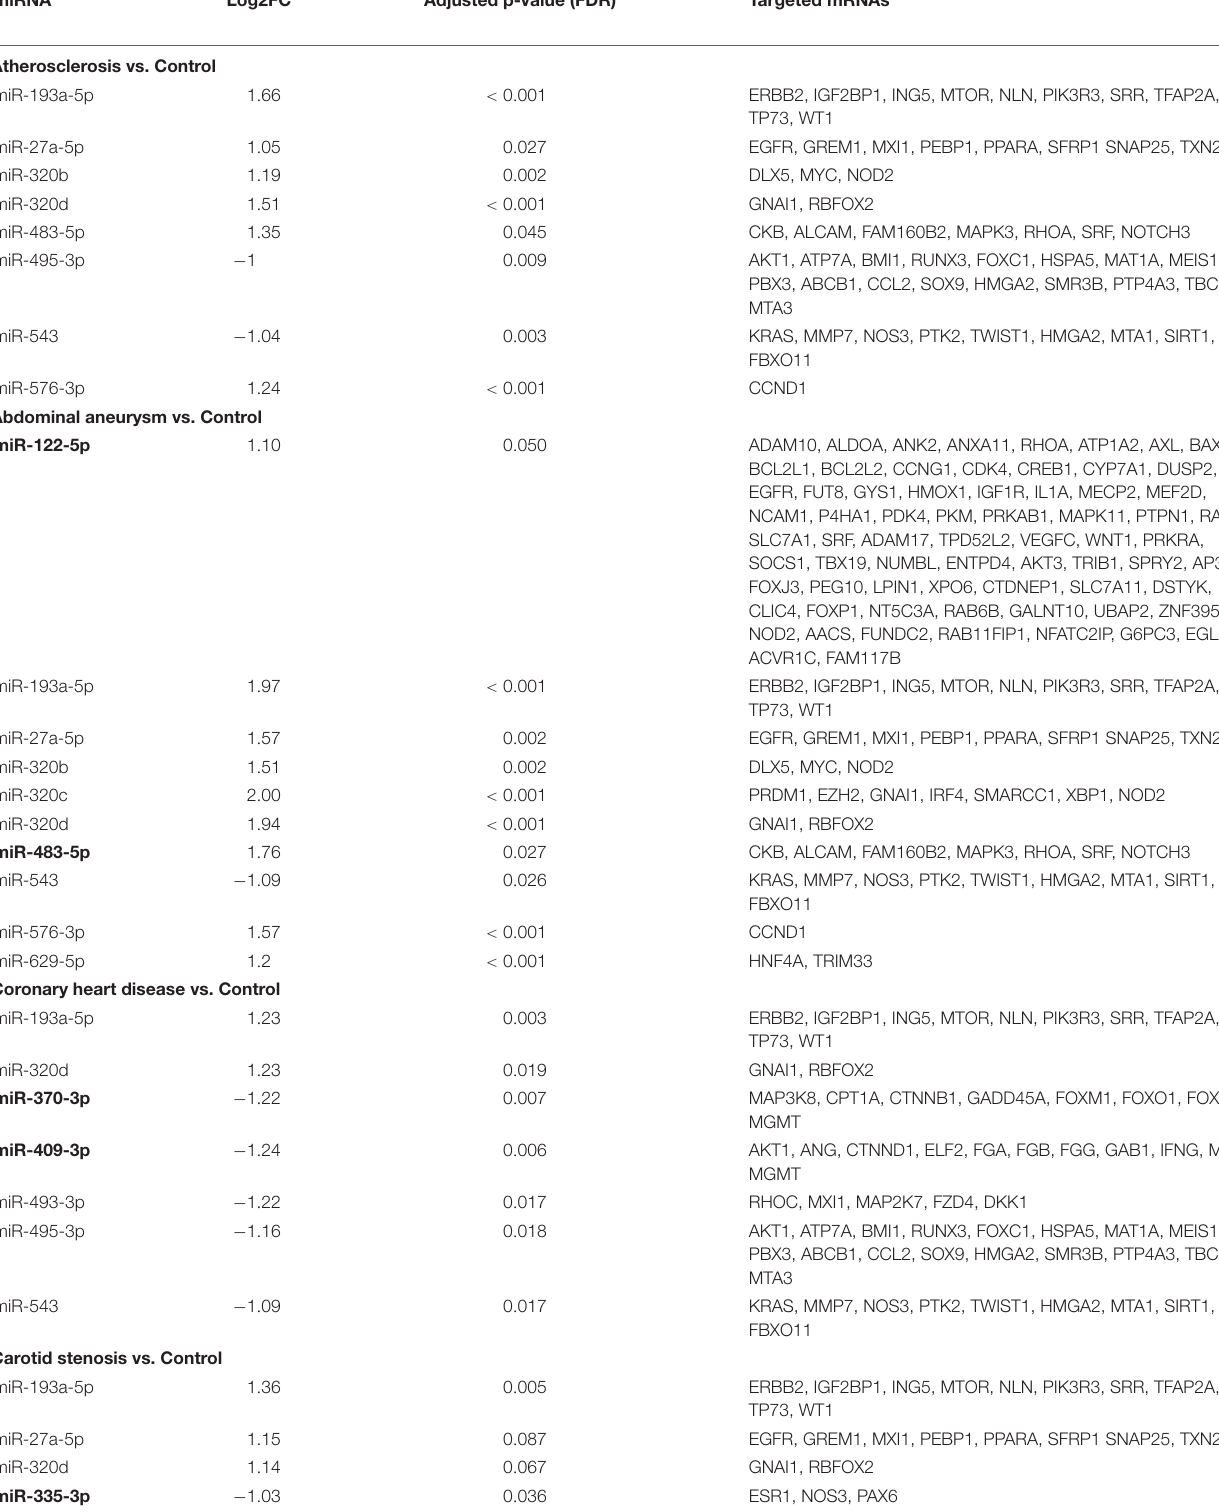
TABLE 6 | Differentially expressed miRNAs and their targeted mRNAs. miRNA Log2FC Adjusted p-value (FDR) Targeted mRNAs